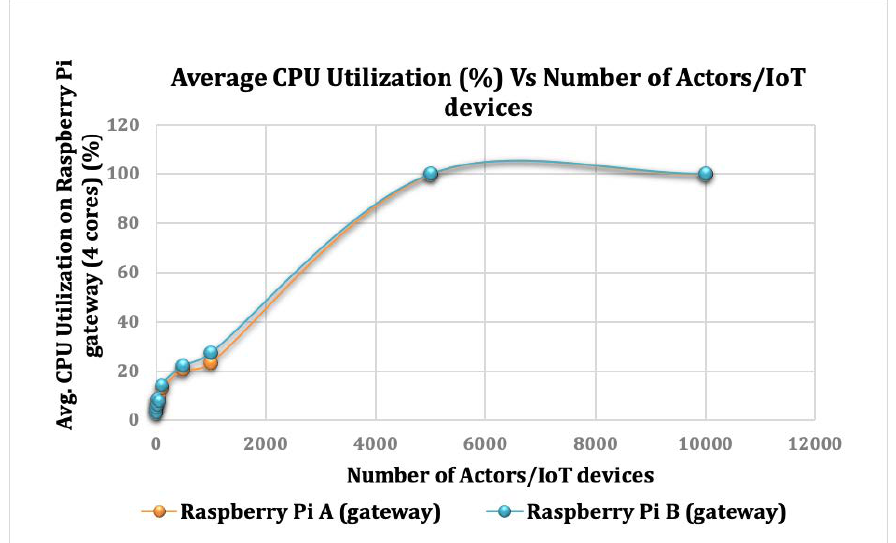
Figure 20. The Effect of Changing the Number of Actors on The CPU utilization of the Raspberry Pi devices.